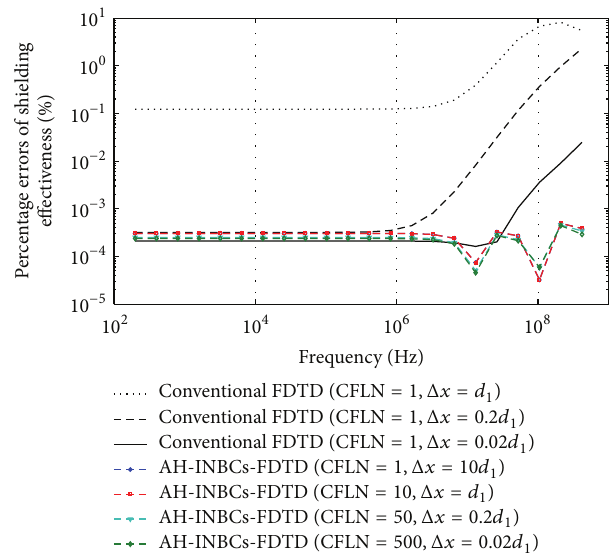
Figure 6: The percentage error of shielding effectiveness compared with analytical solution for the proposed method and conventional FDTD method under different size of space cell Δ𝑥